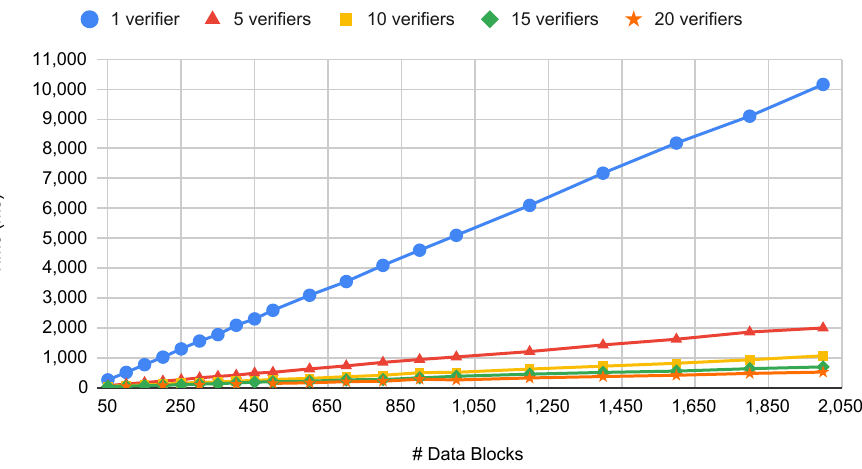
Figure 6. Comparison of verification time using